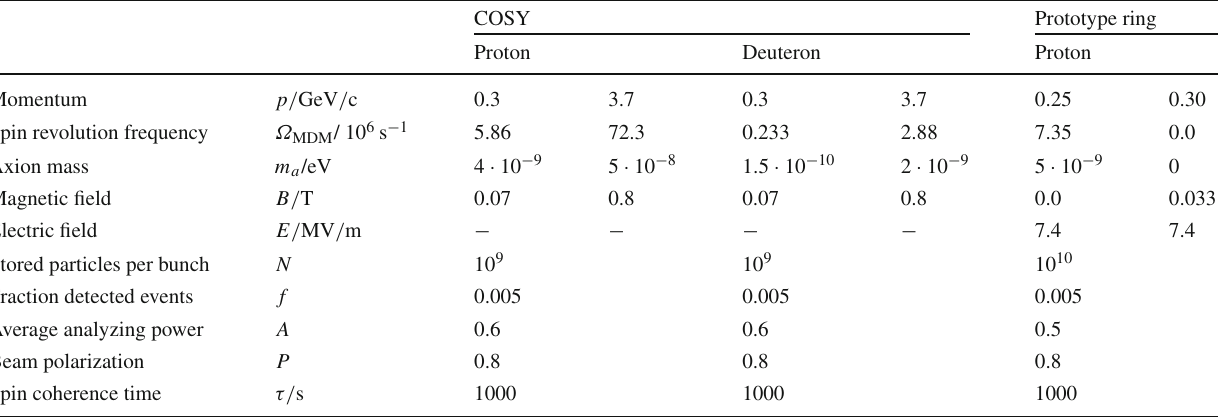
Table 1 Parameters used for the estimates. The ring radius of the prototype ring is R = 8 .